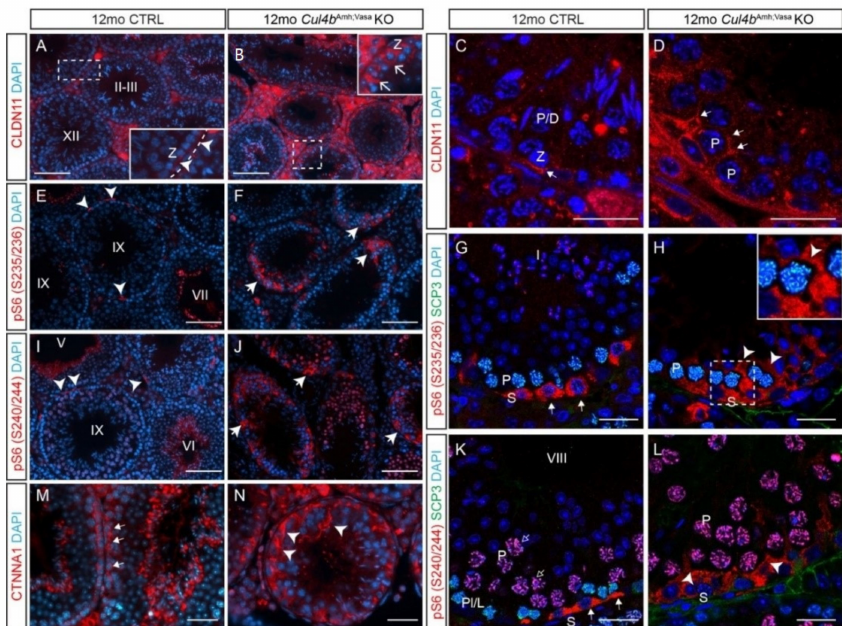
Figure 6. Ablation of Cul4b in both germ cells and Sertoli cells leads to BTB defects. ( A , B ) IF staining and ( C , D ) confocal microscopy of tight junction marker CLDN11 in CTRL and Cul4b Amh;Vasa testis. The insets in A and B are magnified views of boxed areas. Basement membrane outlined by dashed lines in insets. ( E , F ) IF staining of pS6 (S235/236) showing its accumulation in the mutant tubules. ( G , H ) Confocal IF of pS6 (S235/236) (red) and SCP3 (green) showing localization of pS6 (S235/236) in CTRL spermatogonia ( G , arrows), and ectopic activation in the mutant Sertoli cells ( H , arrowheads). ( I , J ) IF staining of pS6 (S240/244) showing its accumulation in the mutant tubules. ( K , L ) Confocal IF of pS6(S240/244) (red) and SCP3 (green) showing its normal expression in spermatogonia ( K , arrows) and ectopic activation in the mutant germ cells ( L , arrowheads). ( M , N ) IF of α -catenin (CTNNA1) showing its accumulation in the mutant testis. S, spermatogonia; P, pachytene spermatocytes; Z, zygotene spermatocytes; Spg,. White dashed lines outline the seminiferous tubules. Scale bars: 200 µ m in ( A , B ), ( E , F ), ( I , J ); 50 µ m in the